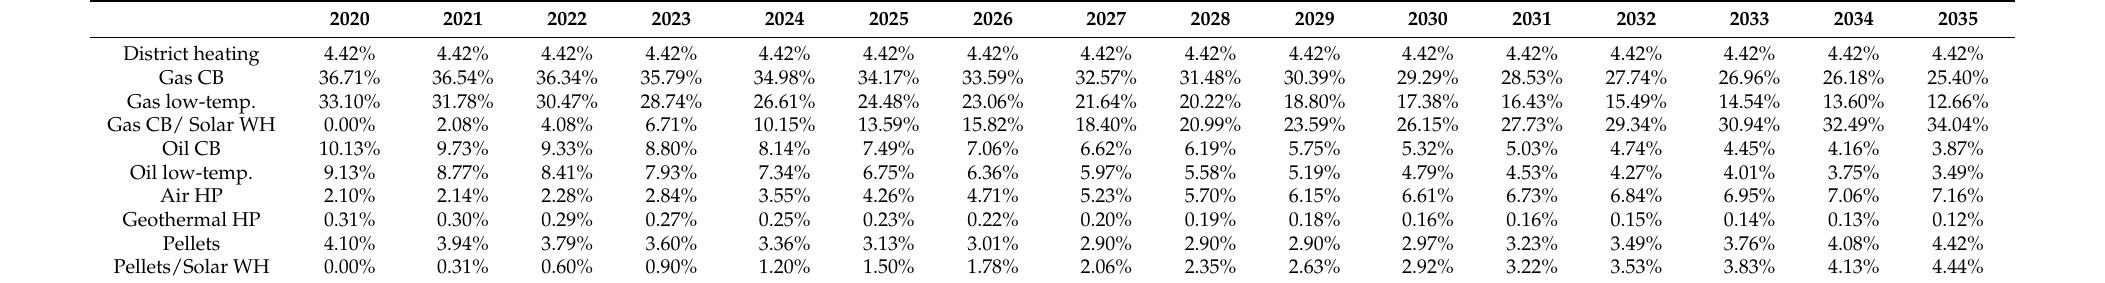
Table A2. Share of technologies “Climate Package” Scenario.